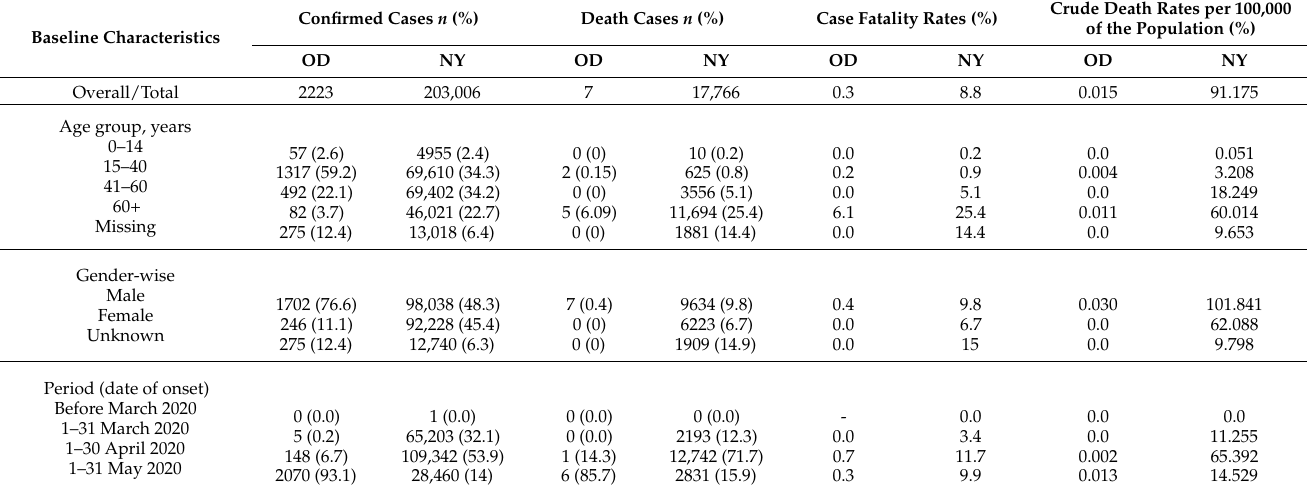
Table 1. Baseline characteristics for confirmed and death cases of COVID-19 as well as case fatality rates and crude death rates in the state of New York and Odisha through 31 May 2020. A total of 203,006 confirmed and 17,766 death cases were reported in NY, and 2223 confirmed and 7 death cases were reported in OD. The ‘Before March 2020’ row includes cumulative data of January and February 2020. Percentages are calculated in parenthesis under confirmed and death case columns. The ‘Missing’ row under the age group column indicates confirmed and death cases without the identification of the correct age group it falls under. The ‘Unknown’ row marked under the gender distribution column indicates confirmed case and death numbers lacking information of the gender category it falls under. Abbreviations: OD, State of Odisha, India. NY, State of New York, USA.